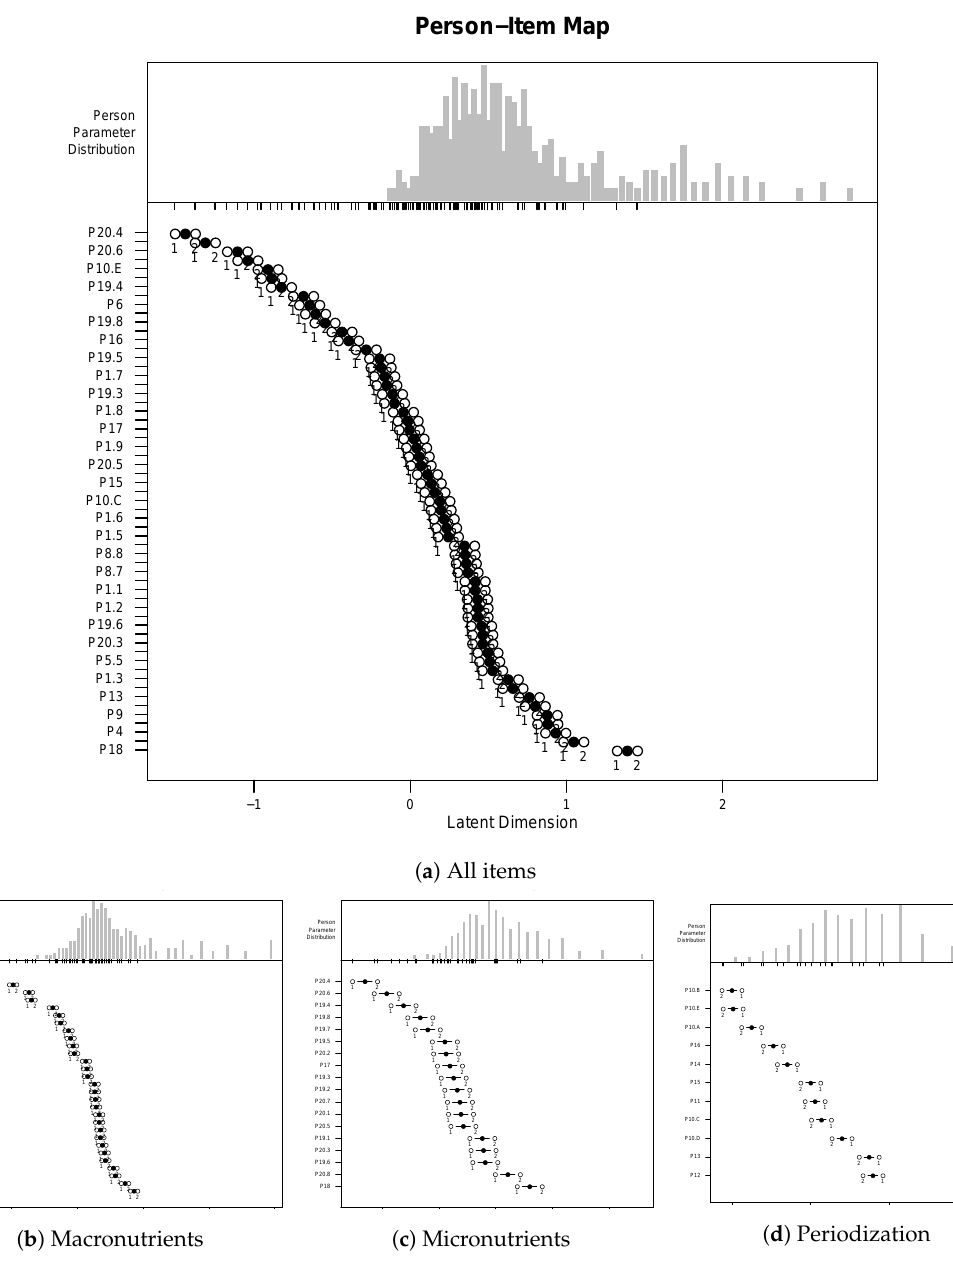
Figure 2. Person–item maps for the fitted rating scales model. (Top) The questionnaire items (y-axis) sorted according to the value they take in the latent dimension (x-axis, negative to positive means easier to more difficult). (Bottom) The person measure distribution. Items should ideally be located along the whole scale to meaningfully measure the ‘ability’ of all